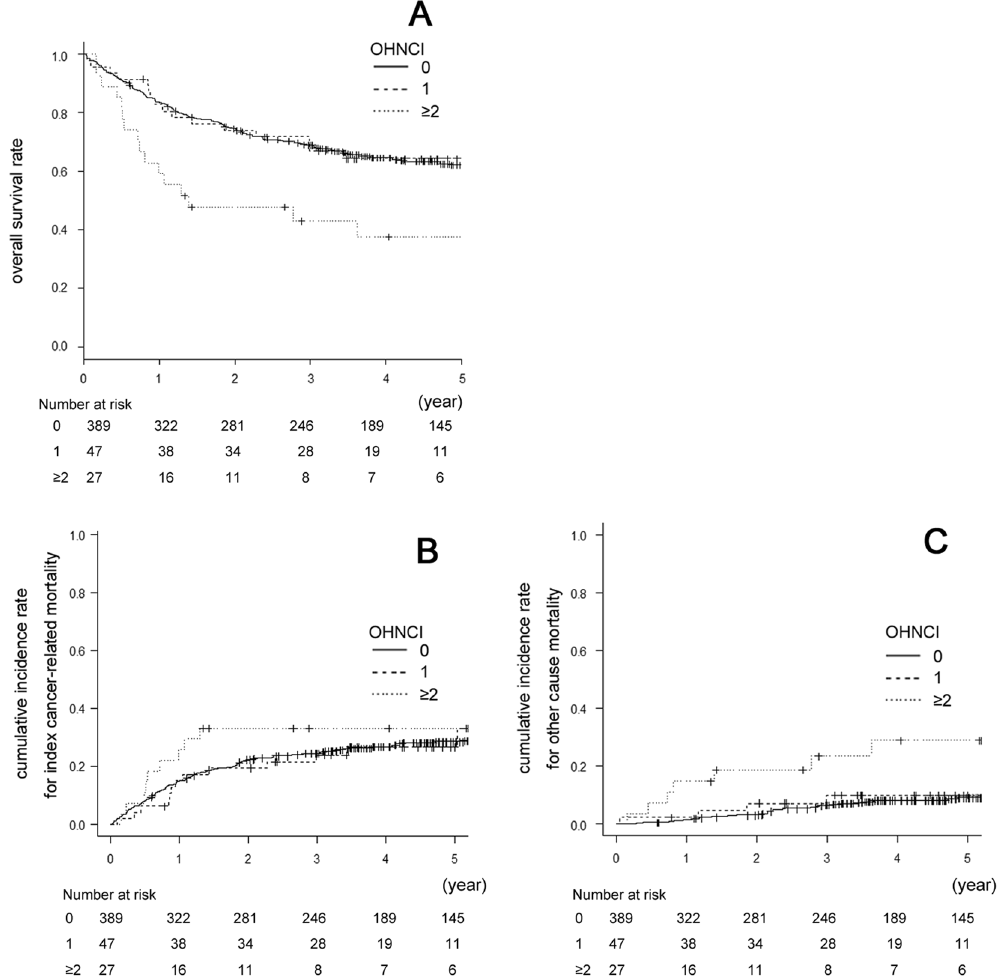
Figure 1. ( A ) Kaplan Meier estimates of overall survival according to OHNCI score. ( B ) Cumulative incidence rates for index cancer-related mortality according to OHNCI score. ( C ) Cumulative incidence rates for other cause mortality according to OHNCI